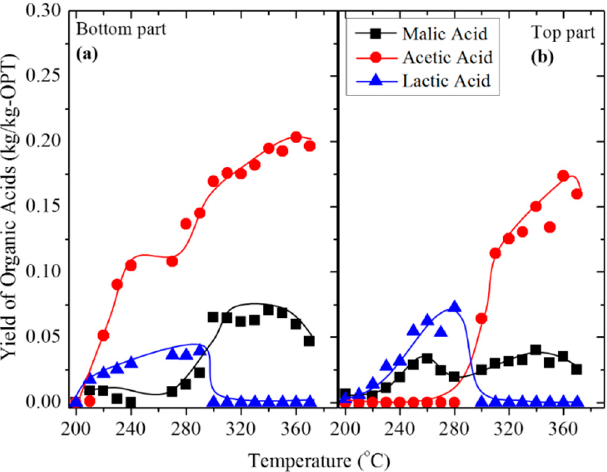
Figure 10. The e ff ect of the reaction temperature on the yield of organic acids after OPT21 was subjected Figure 10. The effect of the reaction temperature on the yield of organic acids after OPT21 was to sub-CW for 5 min. ( a ) bottom and ( b ) top subjected to sub-CW for 5 min. ( a ) bottom and ( b ) top sections.